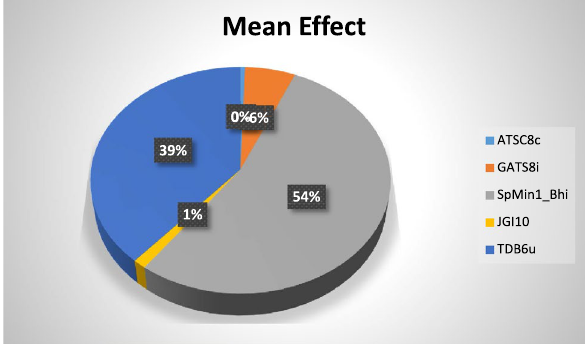
Fig. 3 Descriptors Mean Effect 3-D Pie